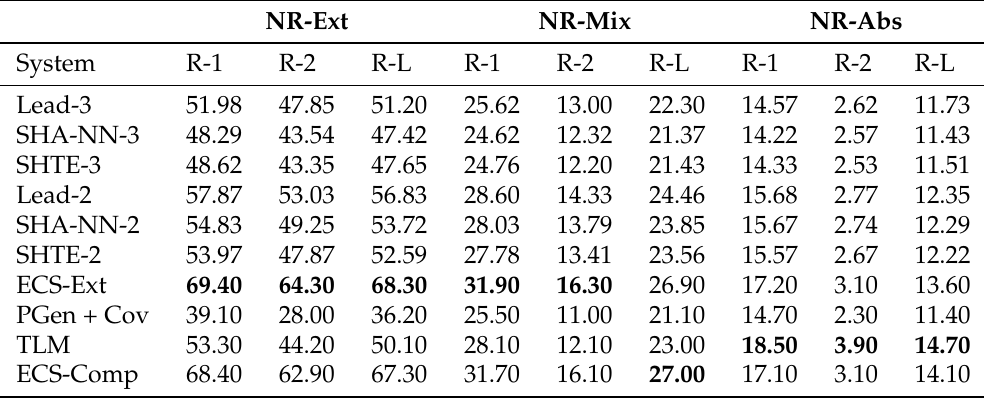
Table 4. Results on the three test subsets of NewsRoom (Extractive, Mixed, and Abstractive). The suffix of Lead, SHA-NN, and SHTE models refers to the number of extracted sentences, k . Best results are in